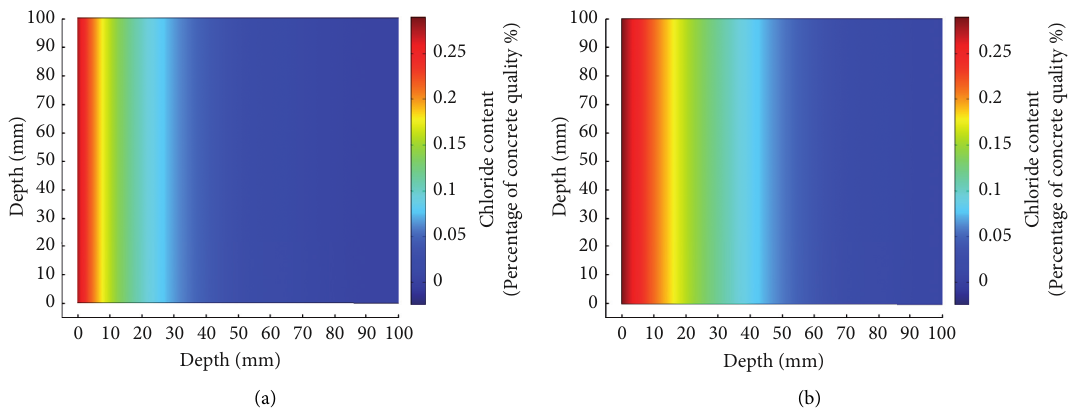
Figure 14: Comparison of chloride coupling migration and pure diffusion in chloride transport model: (a) coupled moisture desorption, saturation 0.75; (b) pure diffusion, saturation 0.75.